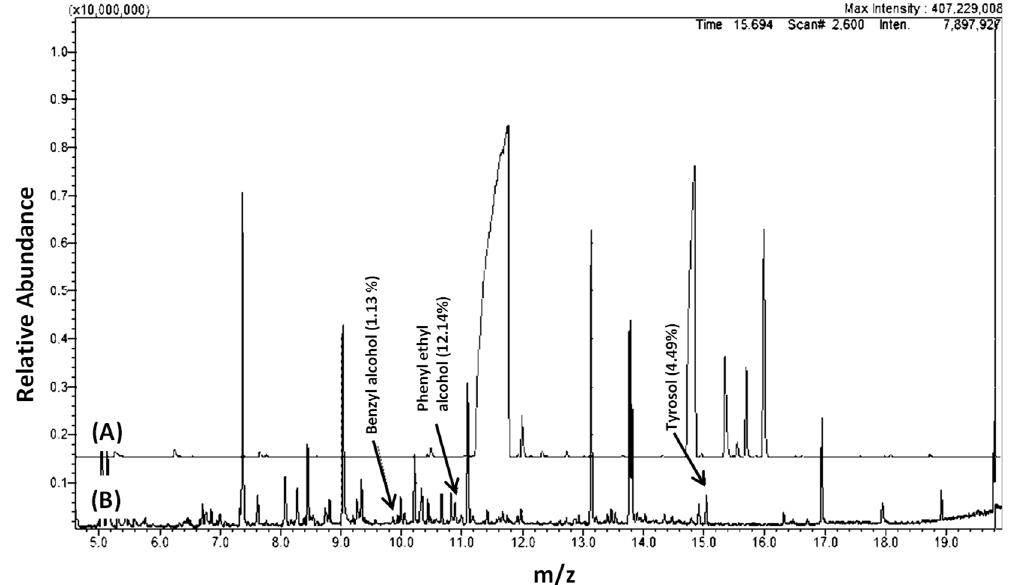
Figure 2. Cont. Figure 2. Cont.